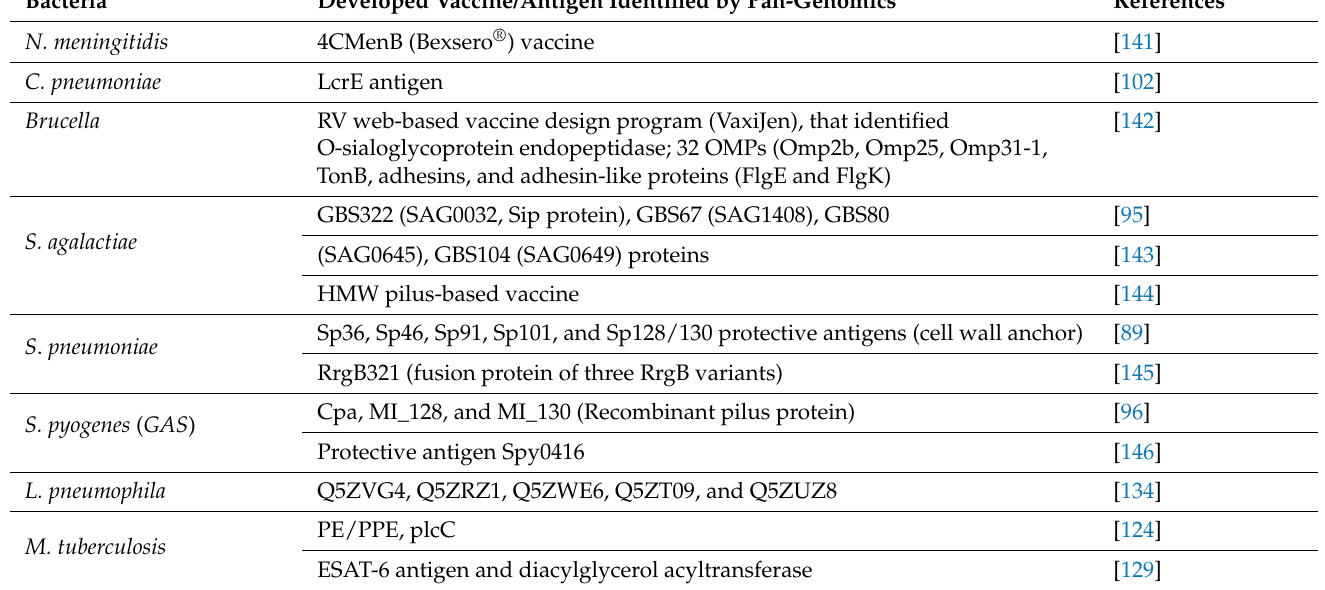
Table 5. Summary of antigens or developed vaccines identified by comparative genomics against various bacterial pathogens. Source data were collected from Schubert and Christodoulides, 2013